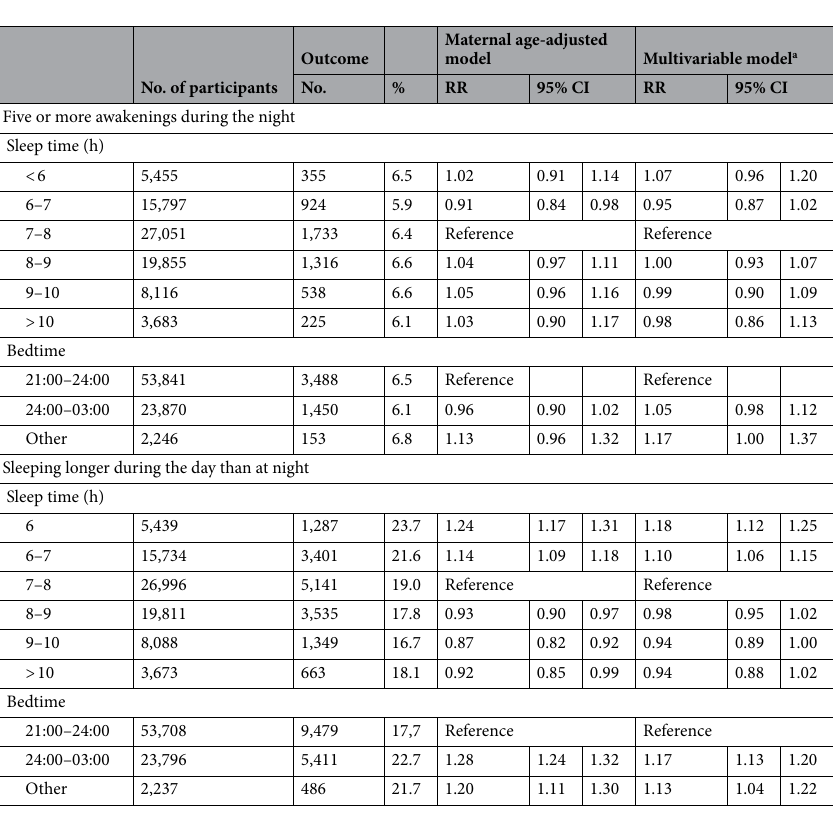
Table 4. Association between sleep before pregnancy and neonatal sleep in the Japan Environment and Children’s Study (2011–2014). CI, confidence interval; RR, relative risk. a Adjusted for maternal age at delivery, smoking habits, alcohol consumption, pre-pregnancy body mass index, gestational age at birth, parity, infertility treatment, infant sex, small for gestational age, type of delivery, and postpartum depressive